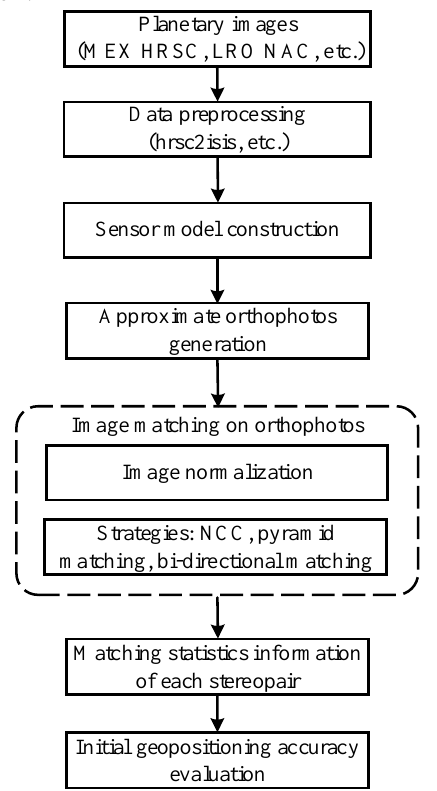
Figure 1. The flow chart of evaluating the initial geopositioning accuracy of planetary images.